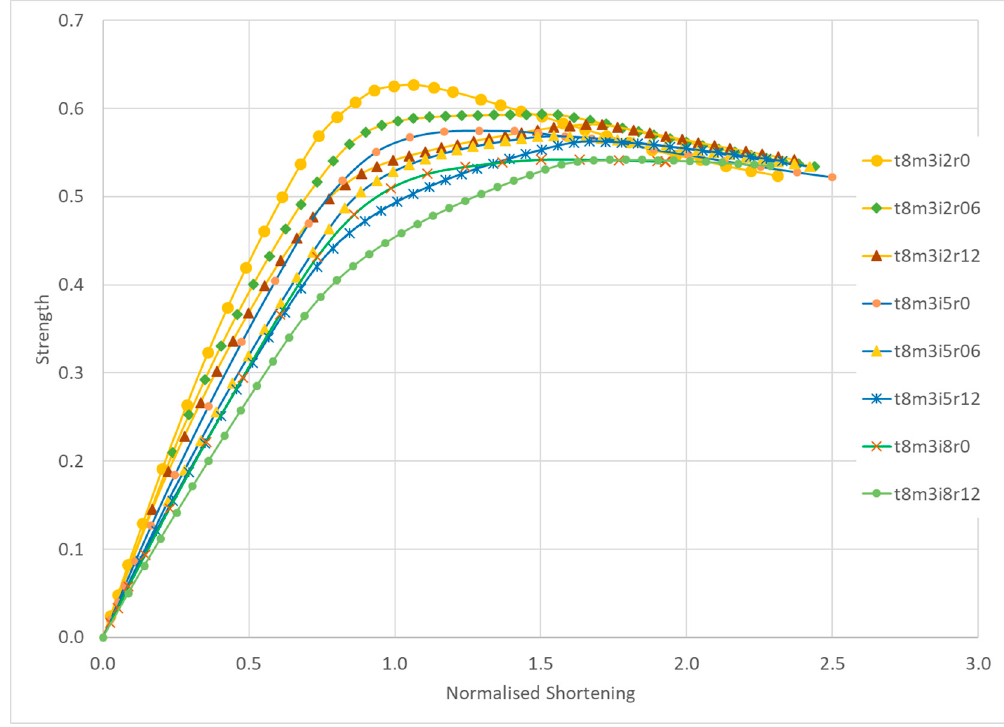
Figure 12. Load shortening curves for very slender plates with different amplitude of initial Figure 12. Loadshorteningcurvesforveryslenderplateswithdifferentamplitudeofinitialimperfections imperfections in critical mode and residual stresses. in critical mode and residual